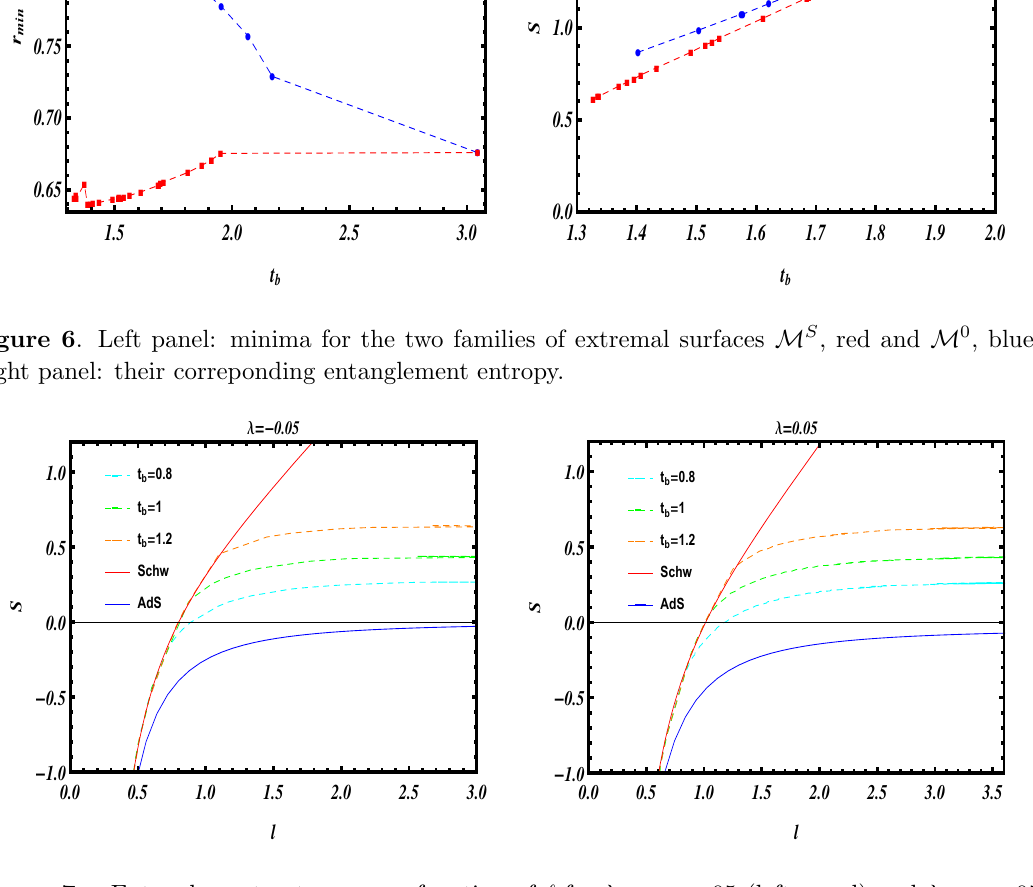
Figure 7 . Entanglement entropy as a function of ‘ for (cid:21) GB = (cid:0) : 05 (left panel) and (cid:21) GB = : 05 (right